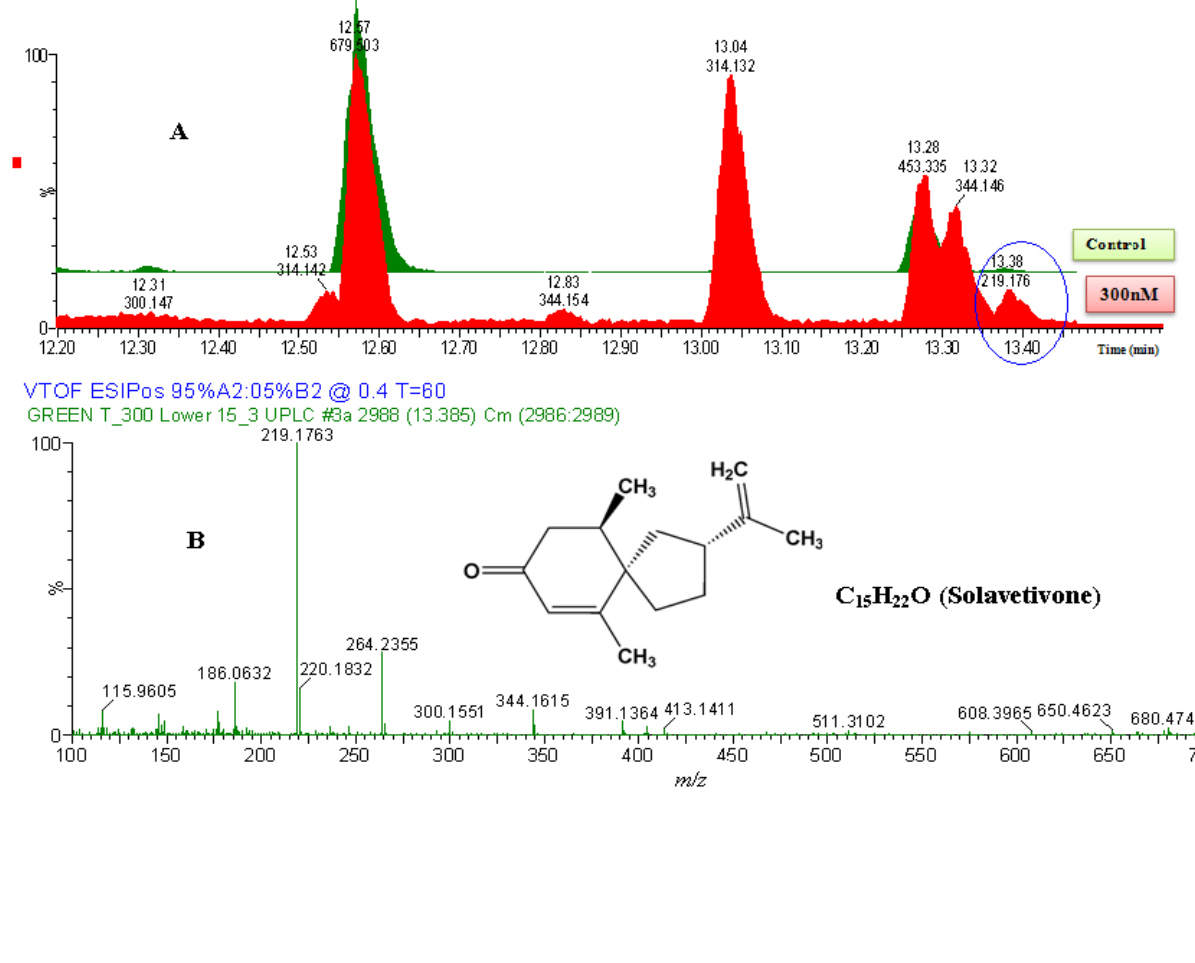
Figure 4. The identification of solavetivone. ( A ) The zoomed-in ESI + -MS TICs comparing non-treated sample (green) and 300 nM-treated sample (red). The encircled ion peak is present only in the treated sample. ( B ) MS-spectrum of the encircled peak, eluted at 13.38 min (219.1763 Da). Based on the spectrum of the extracted ion peak, the empirical formula calculated (and selected) was C H O, with i-FIT of 0.0 and DBE of 4.5. Since 15 23 the ion was generated by ESI + mode, the calculated empirical formula would contain one proton (H + ) extra. The corrected empirical formula is thus C H O; and searching in 15 22 databases (structural correlation to MS spectrum), the compound was putatively identified H O, 218.340 as solavetivone (C 15 22